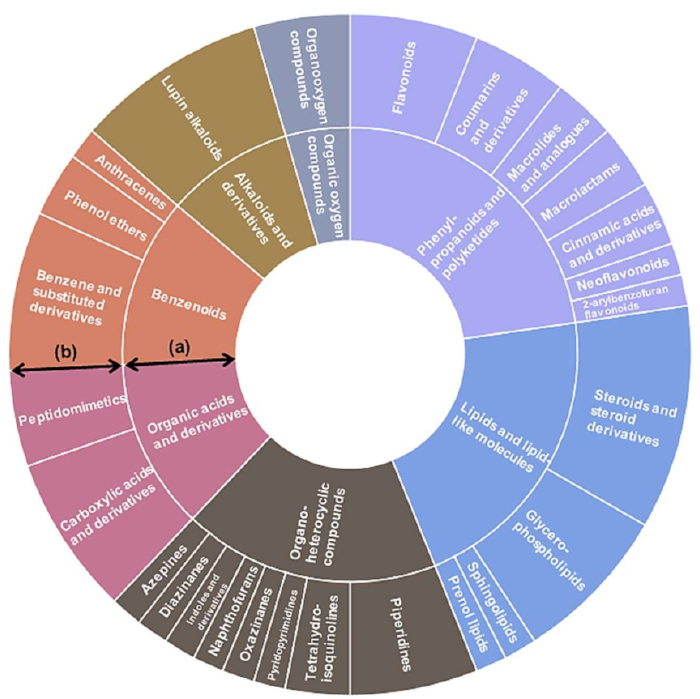
Figure 2. Sunburst plot of organic compounds annotated in Chinese chives. Nodes annotated by NAP were classified as different class levels using ClassyFire. (a) superclass level; (b) class level.